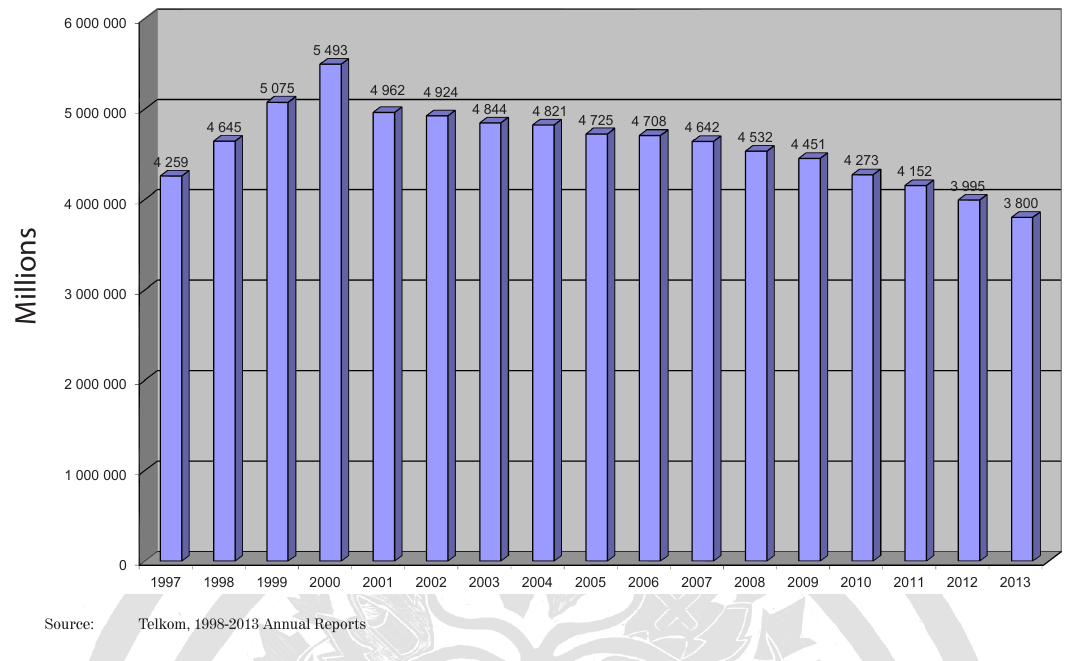
FIGURE 2: SA: FIXED LINES (1997-2013)